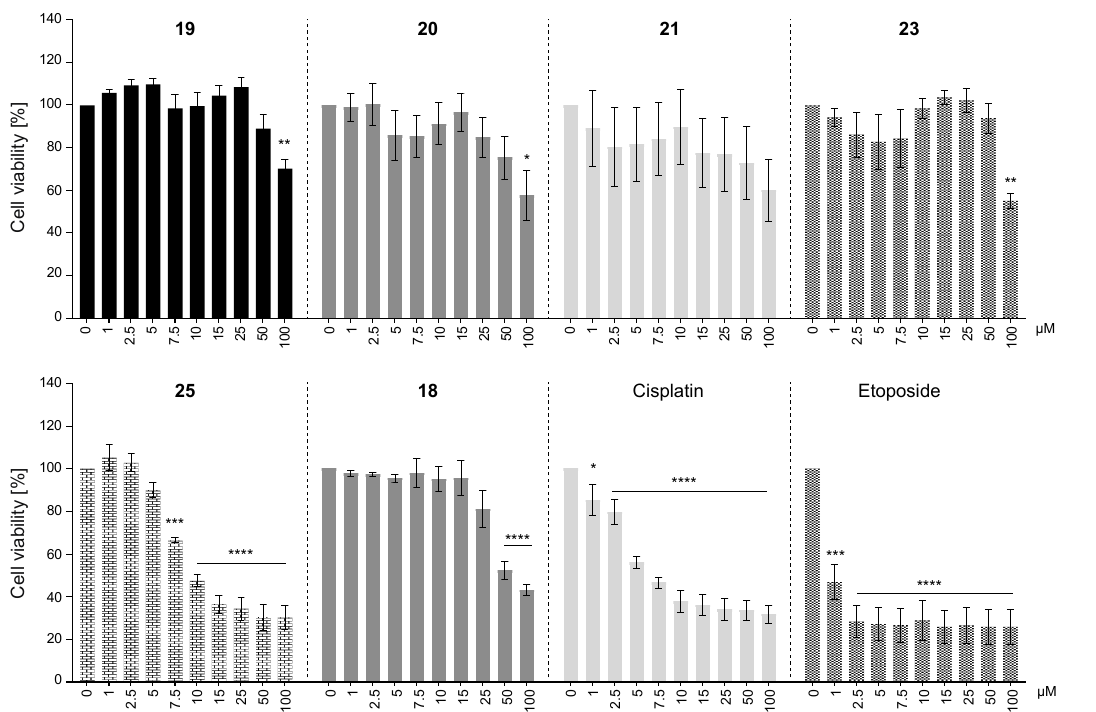
Figure 4. Cytotoxicity of selected chalcones on HEK293T cells. Images display cell viability of HEK293T cells that were treated with 0, 1, 2.5, 5, 7.5, 10, 15, 25, 50, or 100 µM of compounds 19 , 20 , 21 , 23 , 25 , 18 , cisplatin, or etoposide for 72 h. Cell viability at 0 µM compound concentration (vehicle) was set to 100% viability. Mean values ± SEM of three or four independent experiments are shown. One-way ANOVA (Dunnett’s test) was performed for statistical analysis, * p < 0.05, ** p < 0.005, *** p < 0.0002, **** p < 0.0001, compared with the corresponding controls (vehicle treated).